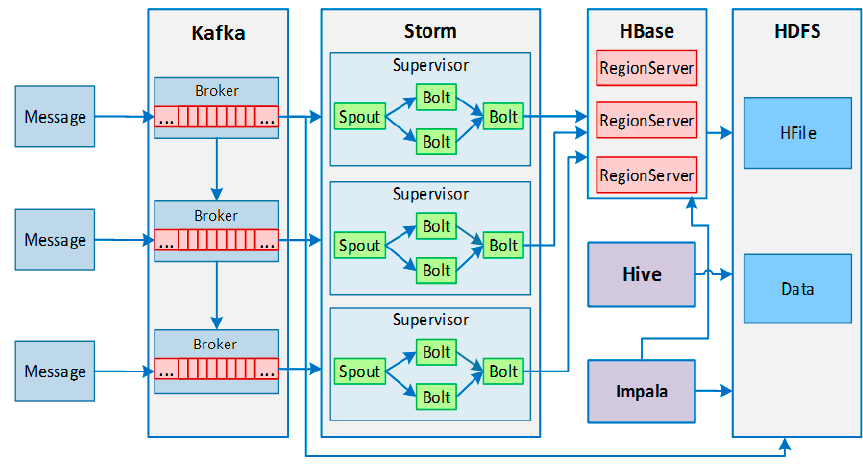
Figure 15. The three-cluster architecture of the cloud tier of EMULSION.